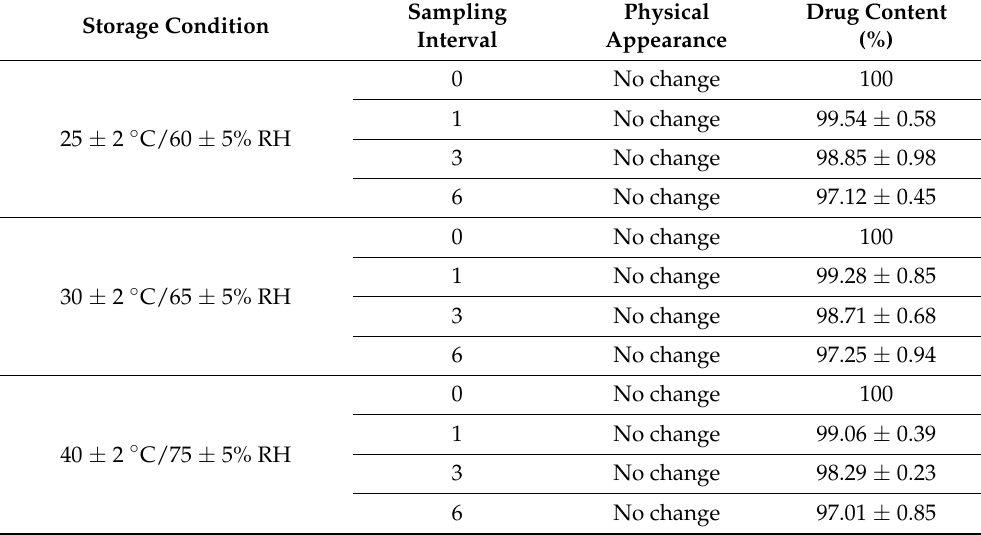
Table 5. Stability study data of the optimized SLN